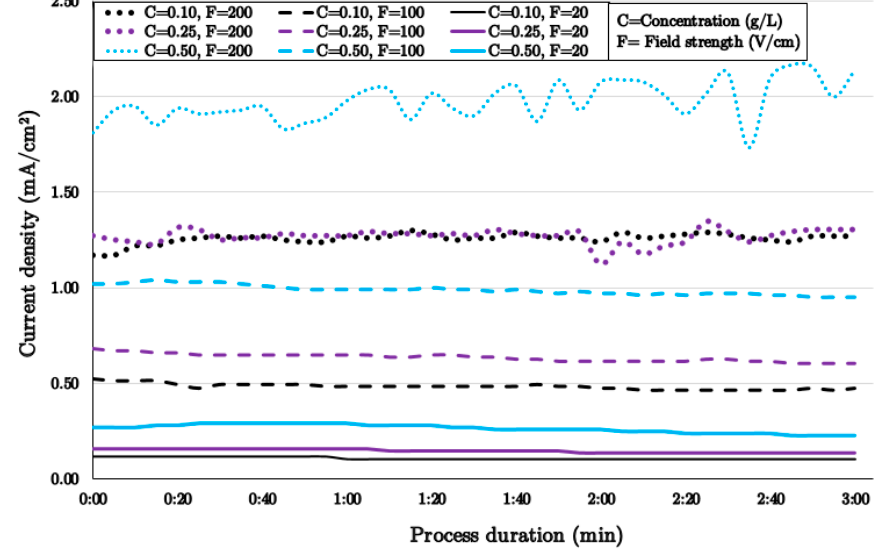
Figure 4. Current density diagrams for different field strength and particle concentration in the EPD process of CNTs on glass fibers.